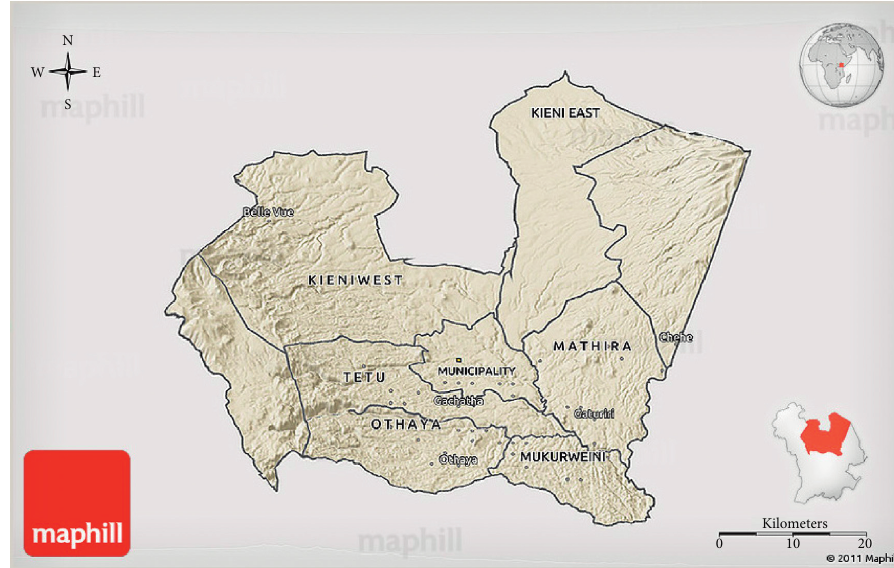
Figure 2: Map of Nyeri County showing the different subcounties (municipality represents Nyeri Central). Map courtesy of